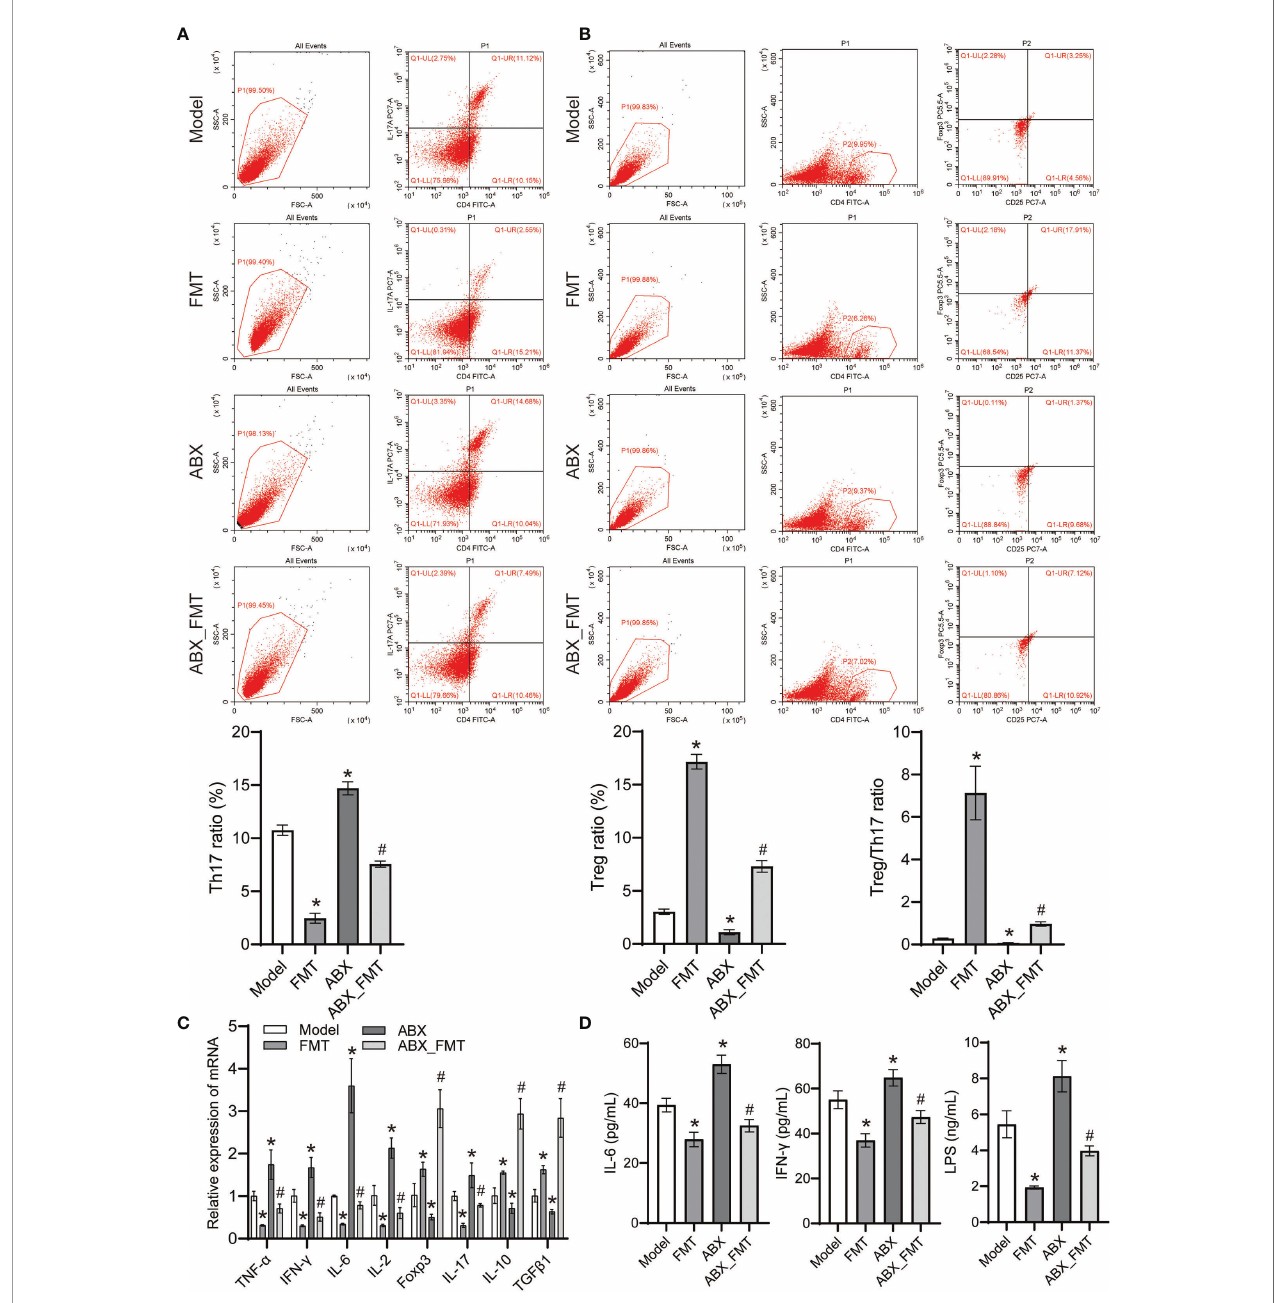
FIGURE 7 | FMT affected Treg cell differentiation and inhibits in fl ammation in mice with acute pneumonia (n=10 mice/group). (A-B) The Treg and Th17 cells ratio in spleen tissues were detected by fl ow cytometry. (C) The expression of TNF- a , IFN- g , IL-6, IL-2, Foxp3, IL-17, IL-10 and TGF b 1 in lung tissue homogenate was detected by qRT-PCR. (D) Serum IL-6, LPS and IFN- g levels were detected by ELISA. *P<0.05 vs control group; #P < 0.05 vs ABX group. Each sample was replicated 3